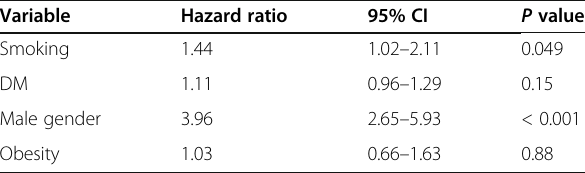
Table 1 Relative risk factors for the current condition